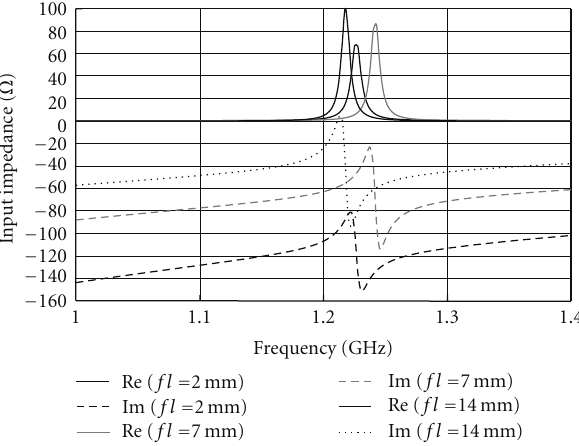
Figure 2: Variation in input impedance of the CFMA with fl .